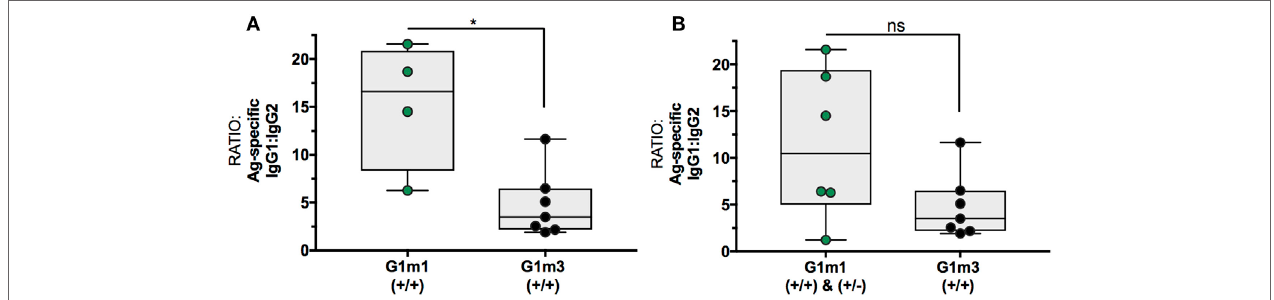
FigUre 3 | Differences in Ag-specific IgG1/IgG2 levels are associated with IgG1-allotypes after the third IM with CN54gp140. Presented data is from MUCOVAC2 and X001 trials and is dose/time matched. (a) Differences in Ag-specific IgG1/IgG2 ratios between homozygous G1m1- and G1m3-carriers ( + / + ). (B) Differences in Ag-specific IgG1/IgG2 ratios between homo-/heterozygous G1m1- and homozygous G1m3-carriers ( + / + ). Non-parametric Mann–Whitney test (* p <